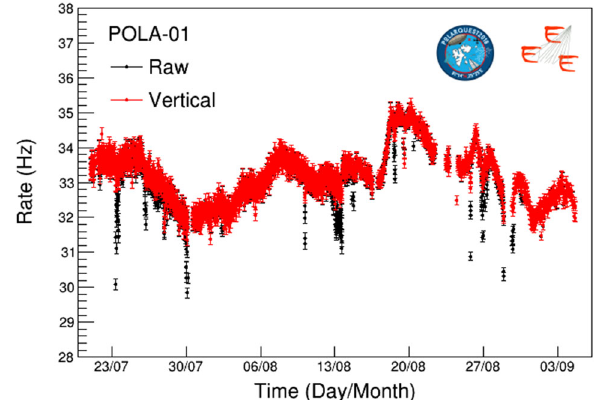
Fig. 21 POLA-01 rate as a function of time from July 22 to Septem- ber 4, 2018. Black points: raw rate; red points: rate corrected for the inclination effect discussed in the